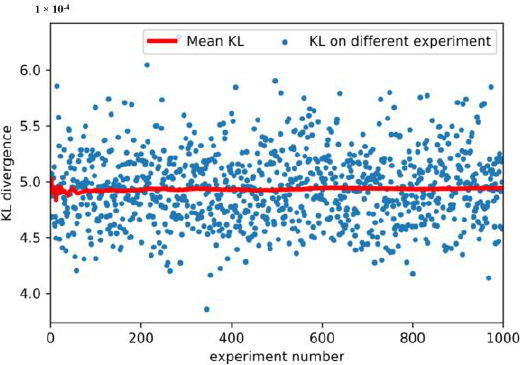
Figure 10. Kullback – Leibler (KL) divergence of the measured dataset and the reconstructed dataset in in tests.